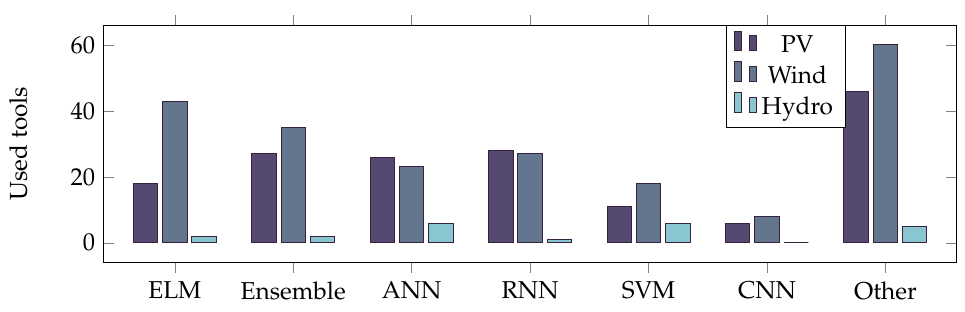
Figure 7. Top ML methods used in particular types of